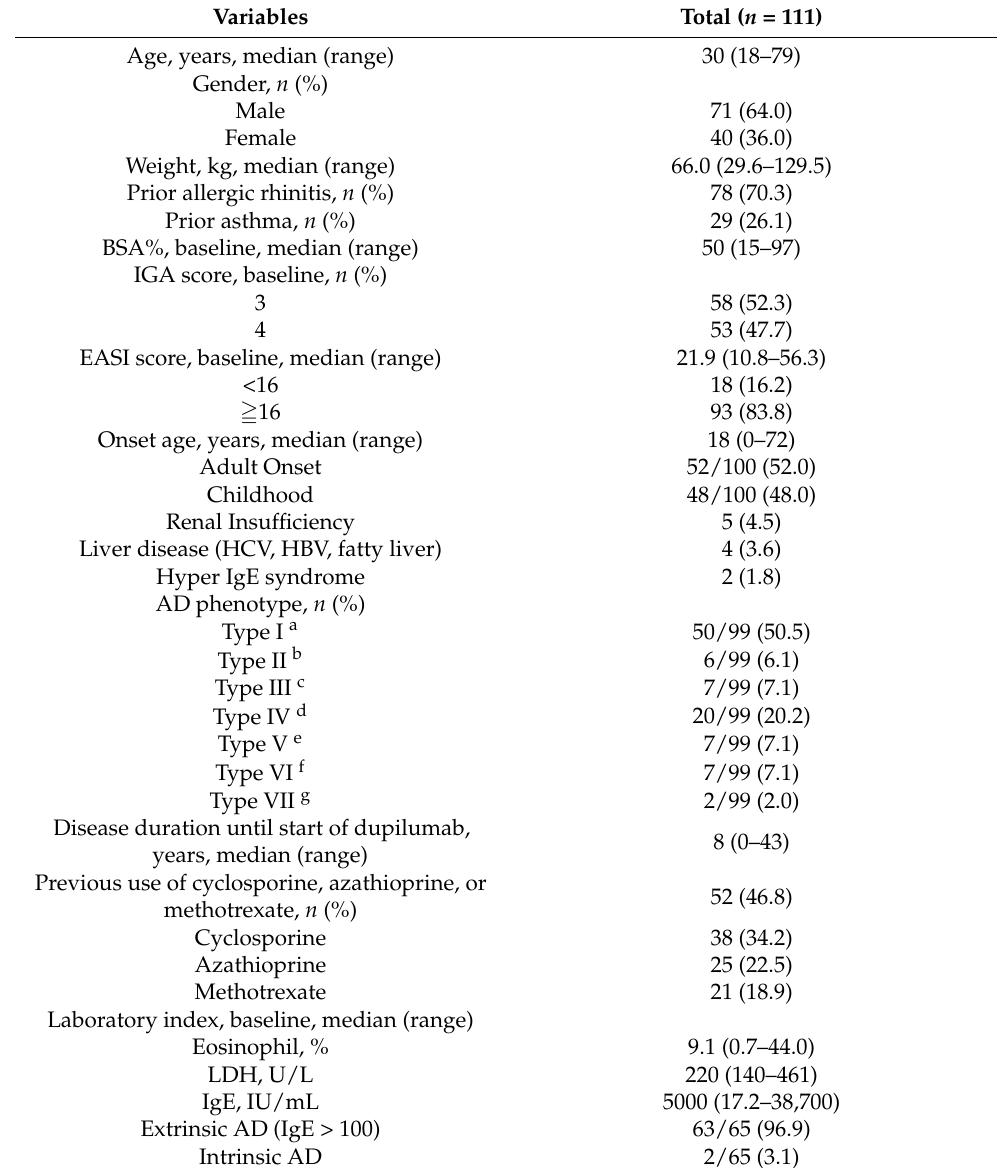
Table 1. Baseline demographic and clinical characteristics of adult patients with moderate-to-severe atopic